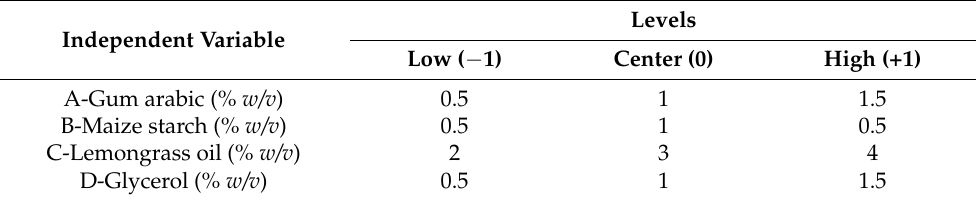
Table 2. Independent variables and the three levels of each factor used in the central composite design